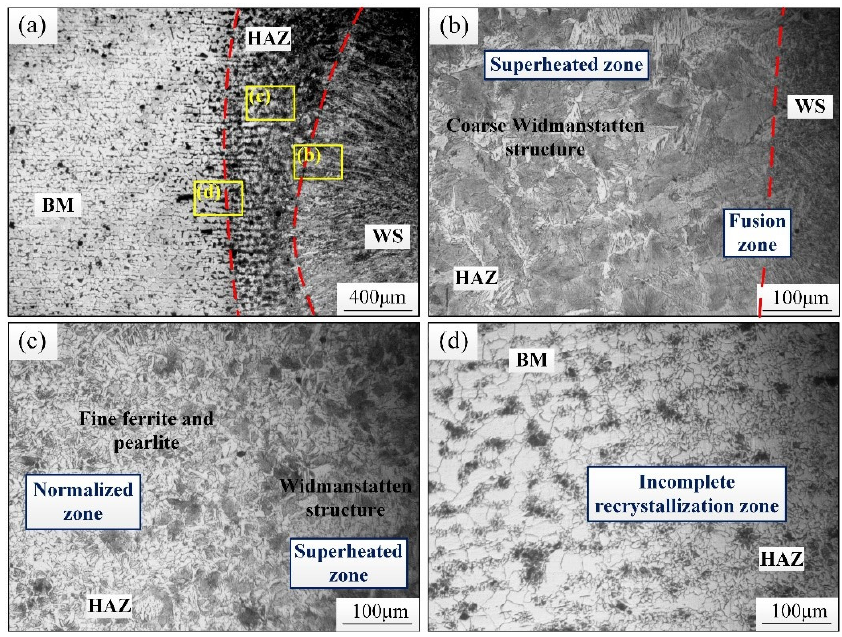
Figure 5. Microstructure morphology of HAZ: ( a ) position of HAZ; ( b ) localized region marked in ( a ); ( c ) localized region marked in ( a ); ( d ) localized region marked in ( a ).